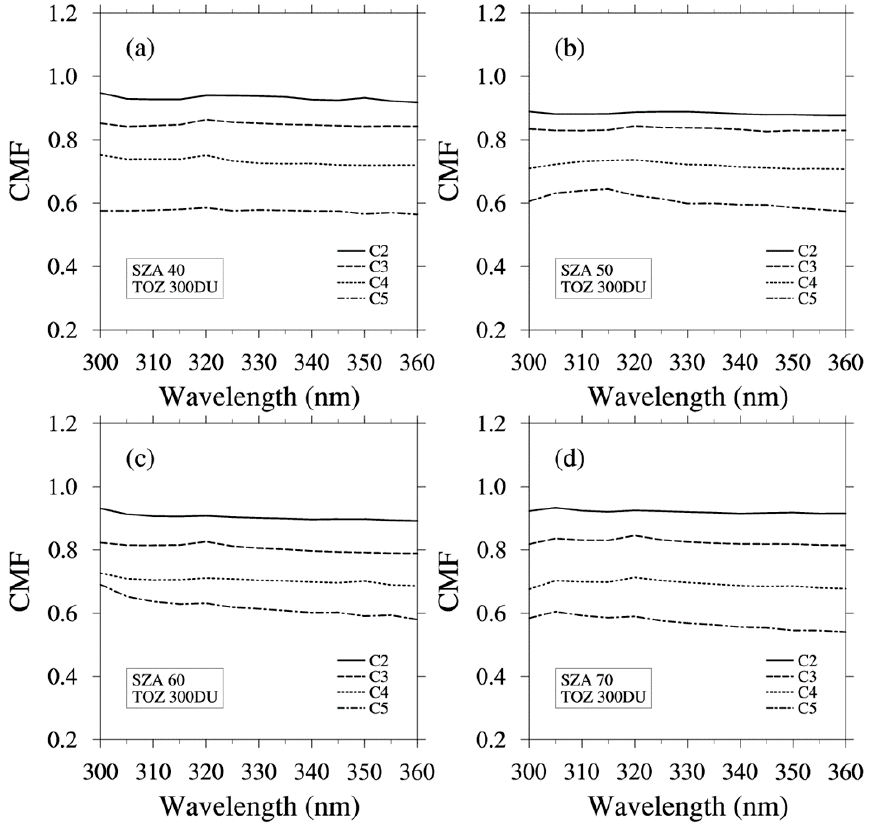
Figure 6. Spectral dependence of CMF of each cloud groups using calculated O3RAF at SZA of: ( a ) 40°; ( b ) 50°; ( c ) 60°; and ( d ) 70°. Table 5. The CMF values as a function of wavelength for each cloud categories. SZA Cloud